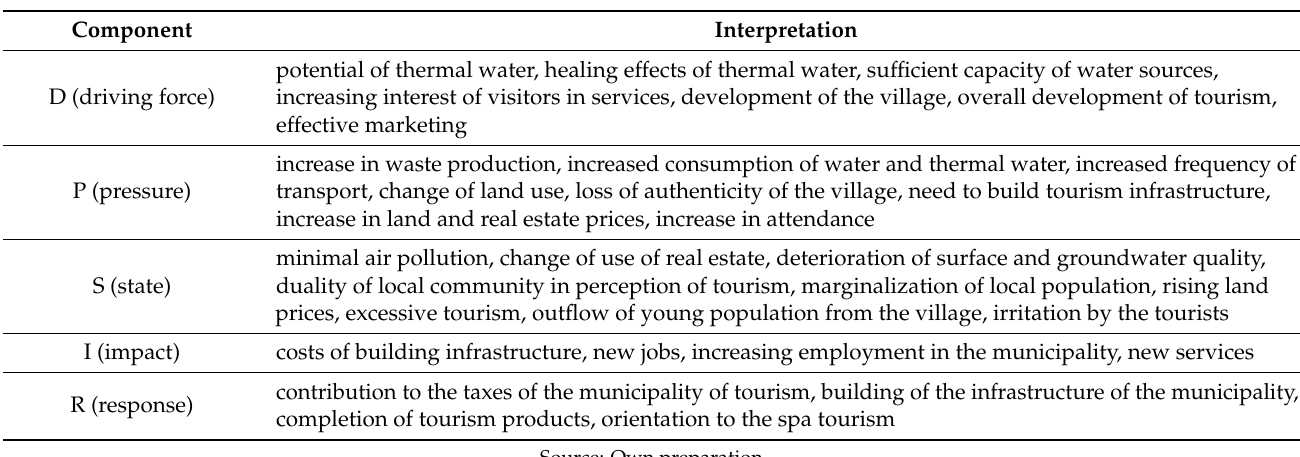
Table 4. DPSIR model for Podh á